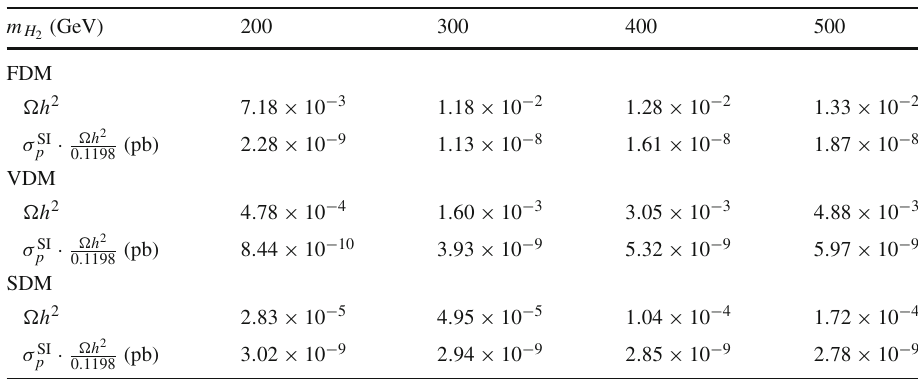
Table 5 Relic densities and direct detection rates of benchmark